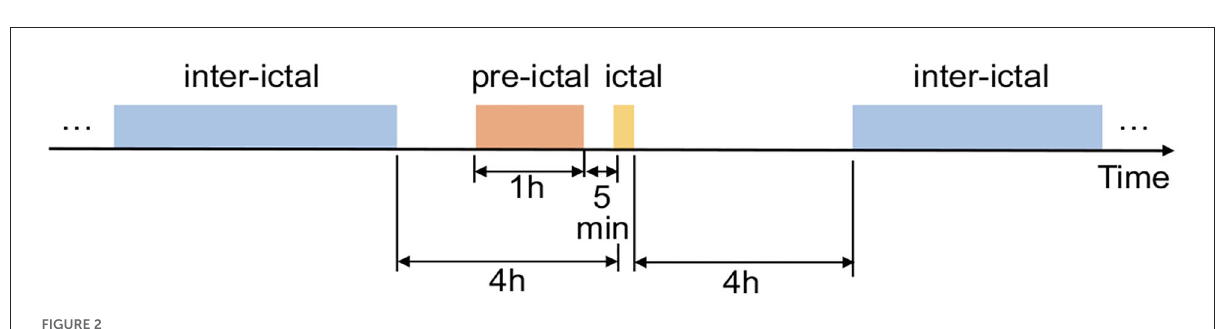
FIGURE2 Epileptic brain